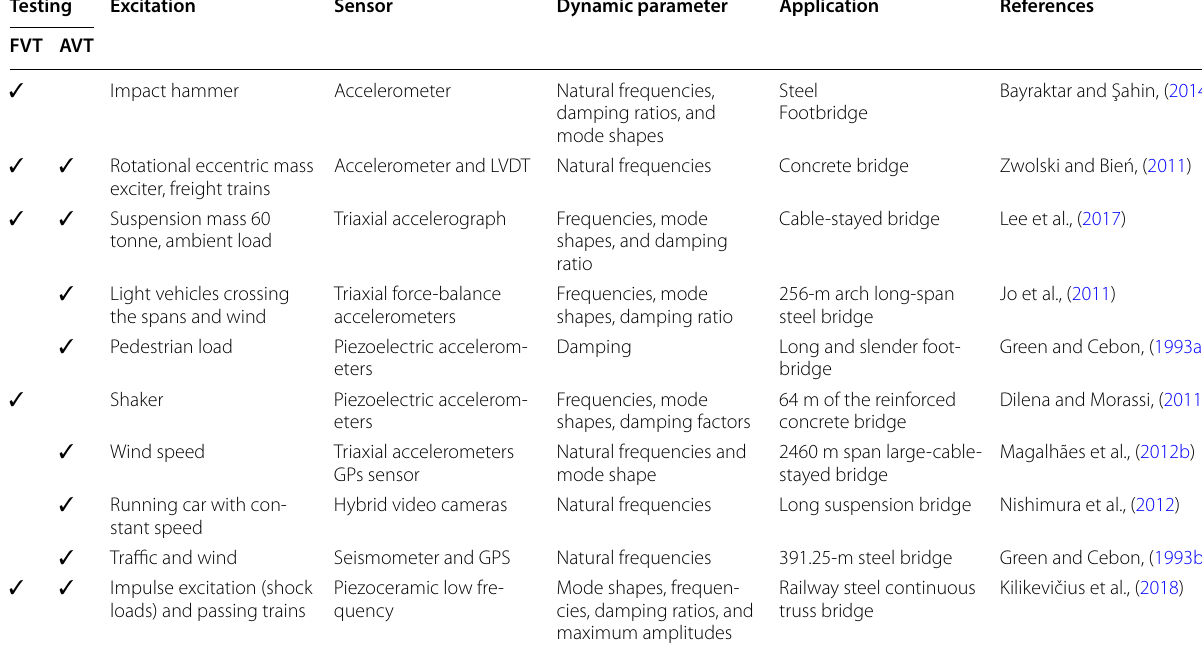
Table 4 Application of dynamic testing in bridge monitoring Testing